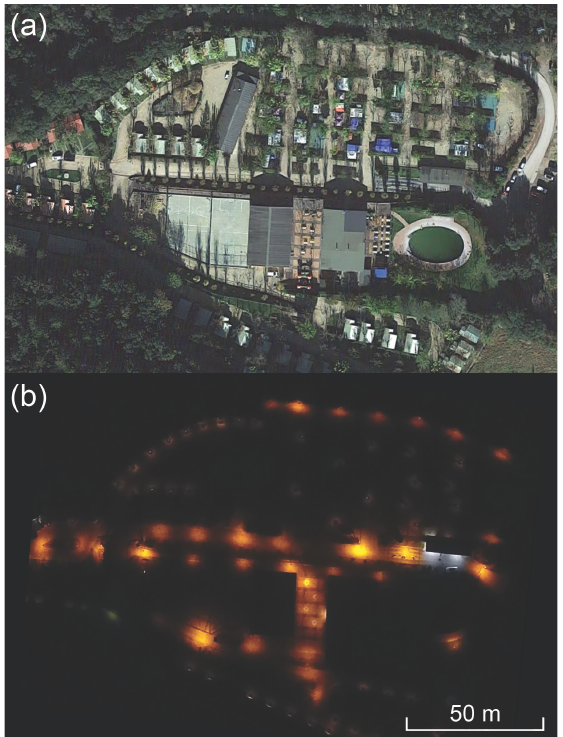
Figure 4. An application of drone-based aerial imagery to the identification of artificial light sources on the ground. ( a ) A daytime satellite image of Bassegoda Park, a camping facility in Girona, Catalonia. Image copyright 2019 Google, INEGI, used with permission. ( b ) A color digital image of the site at night. The image was obtained by a drone flying at an altitude of approximately 100 m above the site. The locations of individual artificial light sources are identified by “pools” of light beneath each, indicating reflection from the ground. The scene is dominated by “warm,” low-pressure sodium lighting, except for two tube fluorescent luminaires near the park entrance station (white sources at right). North is up and east right in both images, and the 50-m scale bar in the lower right corner is common to